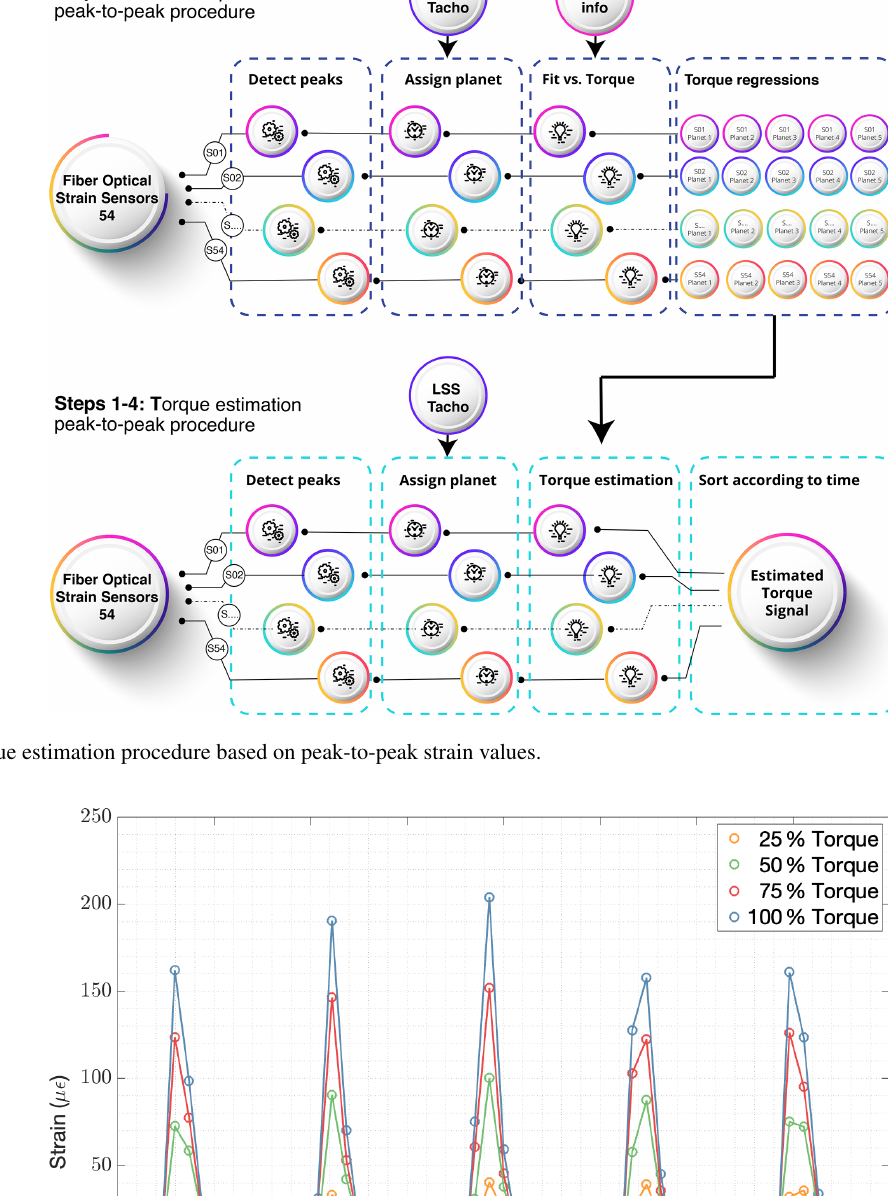
Wind Energ. Sci., 7, 505–521, 2022